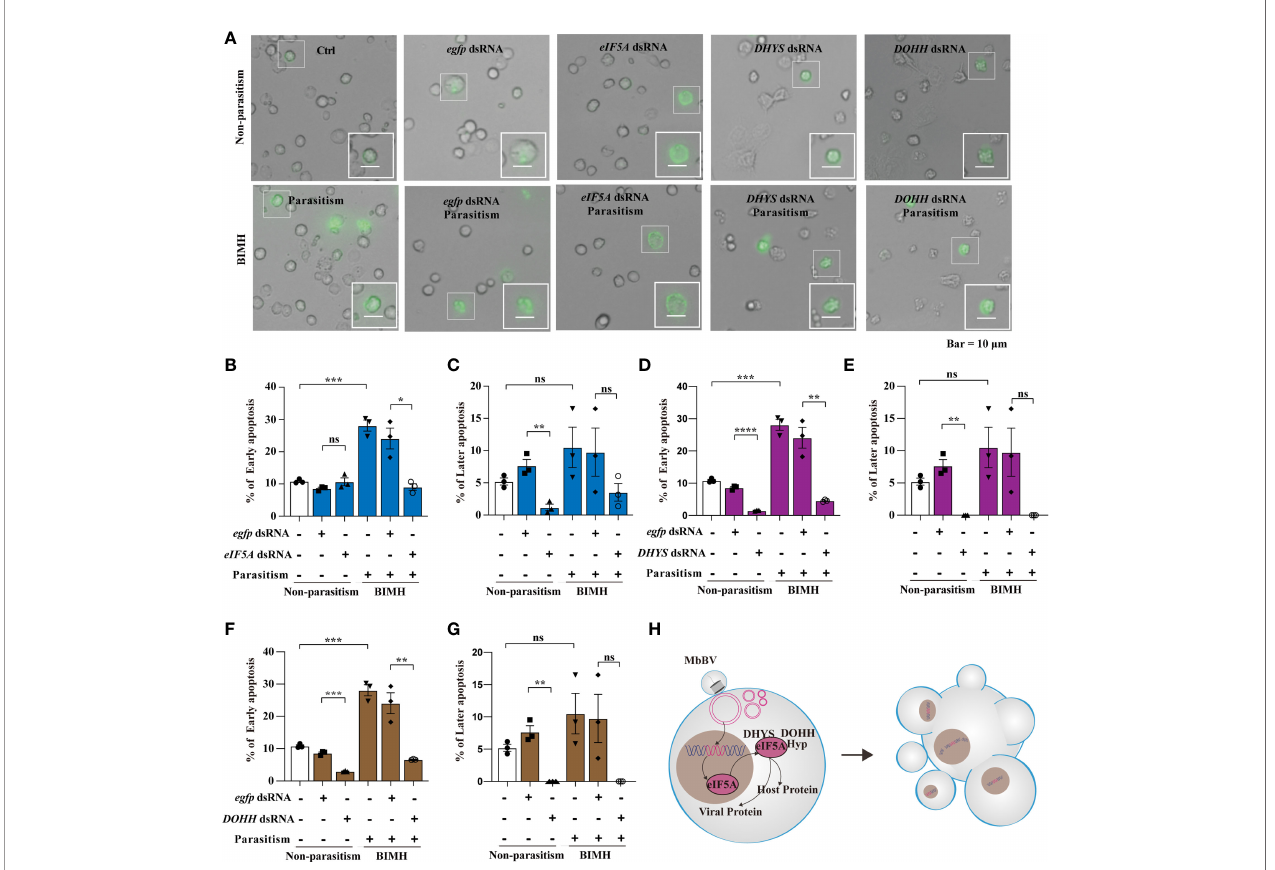
FIGURE 6 | Bracovirus integration-mediated-eIF5A-hypusination drives persistence apoptosis. (A) The effect of RNAi to inhibit hypusine on apoptosis was studied by detecting the apoptotic hemocytes with annexin V-conjugated FITC and PI. Inverted fl uorescence microscopy illustrates the early apoptosis labeled with AnnexinV – FITC (shown in green). Scale bar, 10 m m. This was observed in parasitism under hypusination condition. (B – G) The early and late apoptosis of eIF5A dsRNA, DHYS dsRNA and DOHH dsRNA plus parasitization. * p < 0.05, ** p < 0.01, *** p < 0.001, **** p < 0.0001, ns, no signi fi cant, error bars represent SEM. Unpaired Student ’ s t -test with Holm-Sidak method for multiple t test; n = 3. (H) Illustration of the progress of hypusination triggered by integration of genome promoter in persistent apoptosis. See also Figure S6